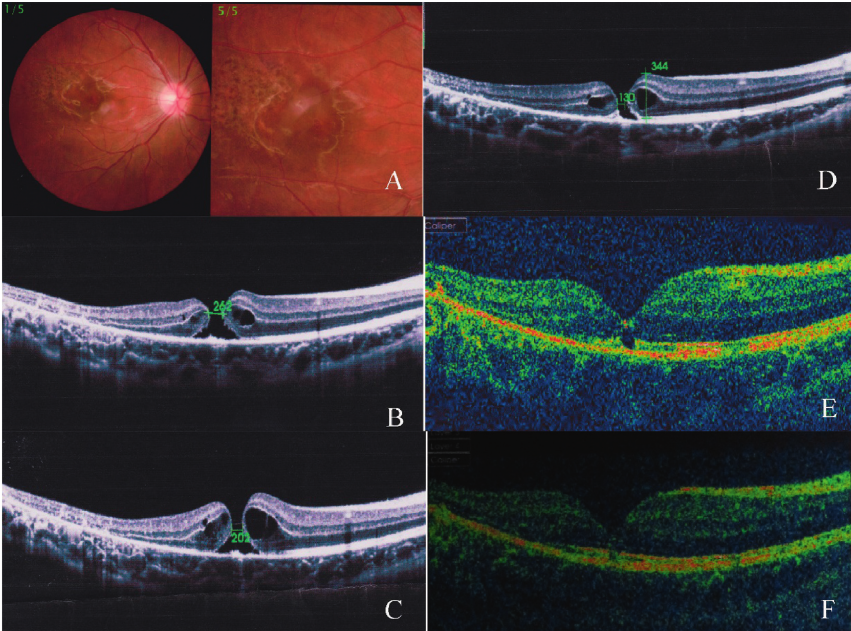
Figure 4: Case 5: a 12-year-old male patient with spontaneous macular hole closure. The patient sustained blunt trauma to the right eye from a racket. His BCVA was 20/63 at initial and improved 20/20 after treatment. (a) Color photo of the same eye 20 days after trauma showing retinal edema. (b) OCT image 20 days after trauma showing FTMH with narrowest diameter of 262 μ m. (c) OCT image 1 month after trauma; narrowest diameter decreased to 202 μ m. (d) OCTimage 3 months after trauma; narrowest diameter decreased to 130 μ m. (e) OCT image 6 months after trauma; part of the ellipsoid band had not regained integrity. (f) OCT image 12 months after trauma; neurosensory retina and ellipsoid band had almost completely regained integrity. Table 2: The relationship between ellipsoid zone and visual acuity prognosis. Ellipsoid band zone Spontaneous closure group Vitrectomy group Fisher’s exact test With 4 4 p � 0.029 Without 0